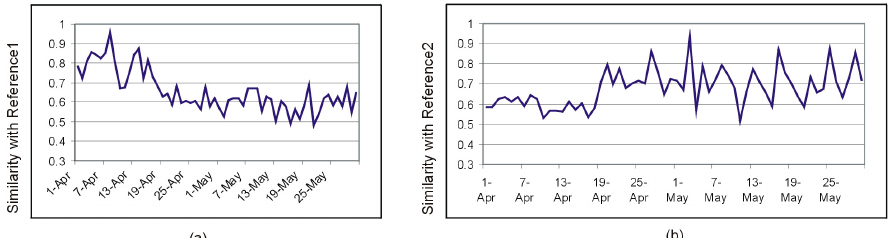
Figure 11. ( a ) The similarity index for the morning hours after comparison with a reference interval before 18 April 2014. ( b ) The similarity index for the morning hours after comparison with a reference interval after 18 April 2014.